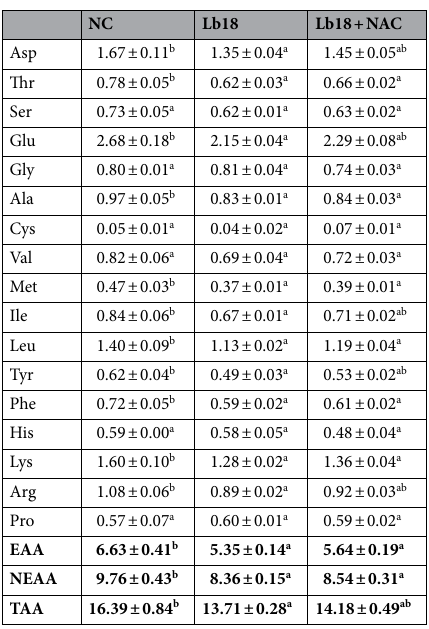
Table 5. Effects of infection with P. vulgaris and E. meningoseptica on amino acids composition analysis of muscle. EAA, essential amino acid (Thr, Val, Met, Ile, Leu, Phe, Lys); NEAA, nonessential amino acid (Asp, Ser, Glu, Gly, Ala, Cys, Tyr, His, Arg, Pro); TAA, total amino acid. Values represent the mean ± S.E. (n = 3 replicate tanks), 3 turtles were sampled for each tank. Values within the same row having different superscripts are significantly different ( p < 0.05).